Question: Generate an informative caption for the figure above.
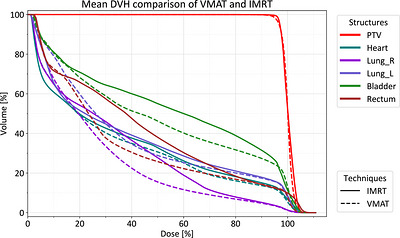
Answer: Mean DVH comparison between adaptive 9‐field IMRT plans generated within the OSCAR workflow (solid lines) and corresponding VMAT plans optimized in Eclipse (dashed lines), with dose values normalized to the prescribed dose.